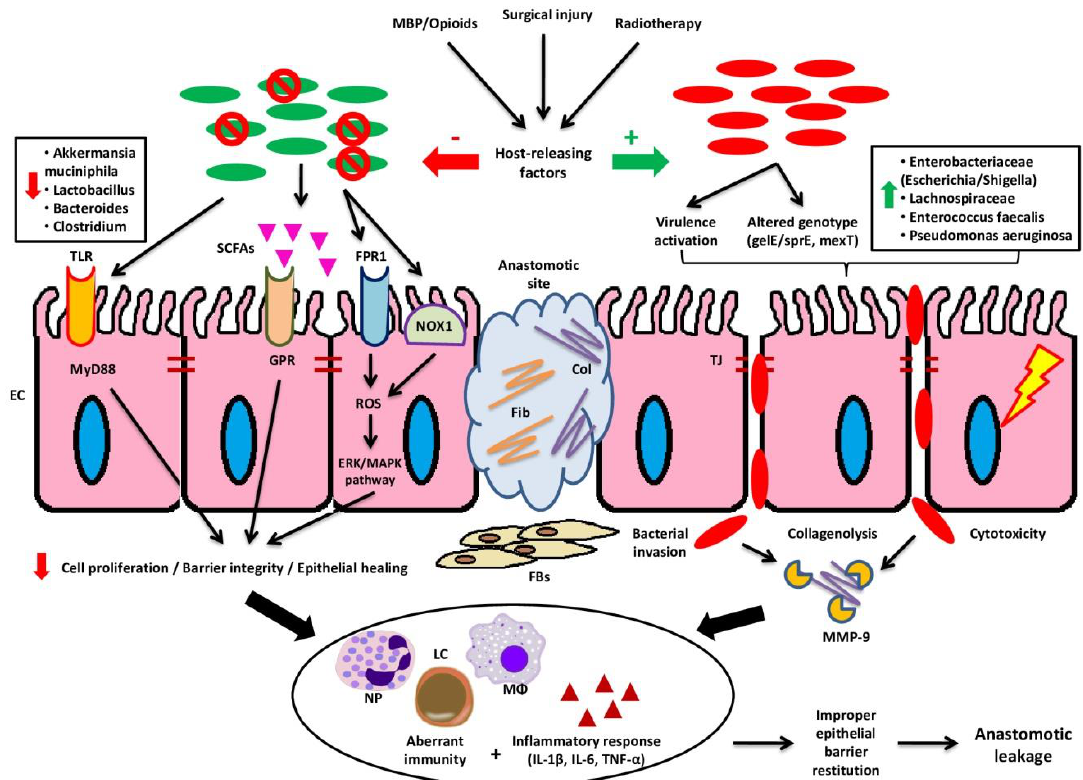
Figure 1. Events after colorectal surgery leading to AL. Surgical injury following colorectal resection combination with perioperative interventions (MBP, opioids, and radiotherapy) trigger the release of various host-derived factors. These factors interfere with the intestinal microbiota at the anastomotic site causing shifts. Physiologically, microbiota promotes colonic cell proliferation and epithelial healing and enhances the integrity of the intestinal barrier, mainly through the stimulation of TLRs, release of SCFAs (e.g. butyrate), and interaction with FPR1 and NOX1 causing the release of ROS and upregulation of the ERK / MAPK pathway. However, the deleterious effects of the aforementioned factors result in reduction of beneficial members of microbiota, thus suppressing normal wound healing. Moreover, several pathogens are increased demonstrating virulence activation and altered genotype. These effects lead to bacterial invasion through failure of epithelial tight junctions, collagenolysis through the activation of MMP-9, and cytotoxicity. The transformation of the intestinal microbiota into a “pathobiome” results in aberrant immunity and inflammatory response, which impair the proper epithelial restitution, eventually leading to the pathogenesis of AL. AL: anastomotic leakage; Col: collagen; EC: epithelial cell; ERK: extracellular signal-regulated kinase; FBs: fibroblasts; Fib: fibrin / fibronectin; FPR: formyl